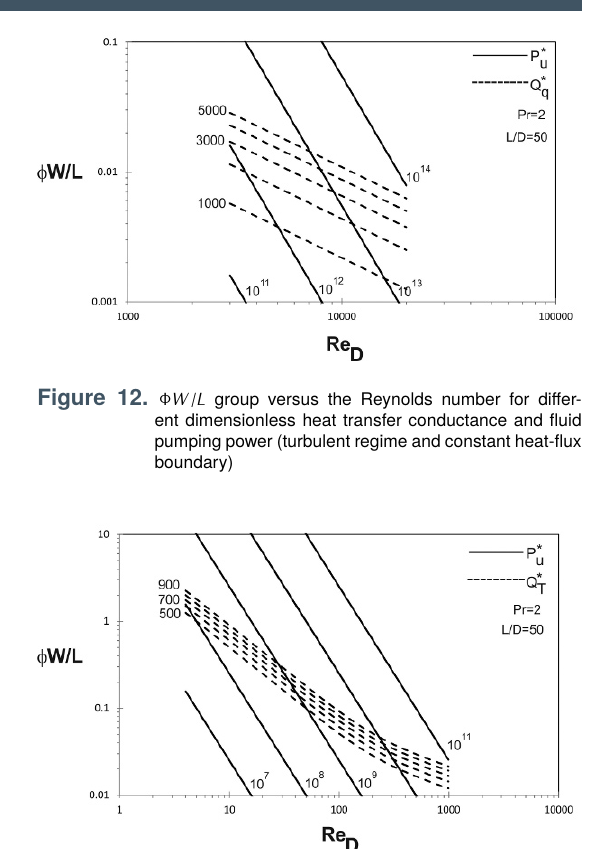
Figure 13. Φ W/L groupversustheReynoldsnumberfordifferentdi- mensionless heat transfer conductance and fluid pump- ing power (laminar regime and prescribed wall tempera- ture boundary)